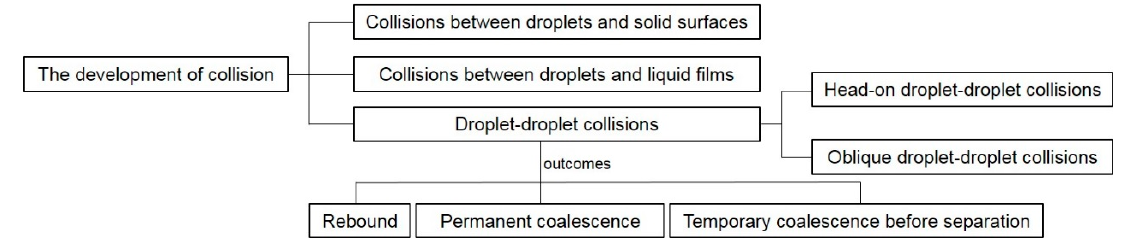
Figure 1. The development of droplet collisions.